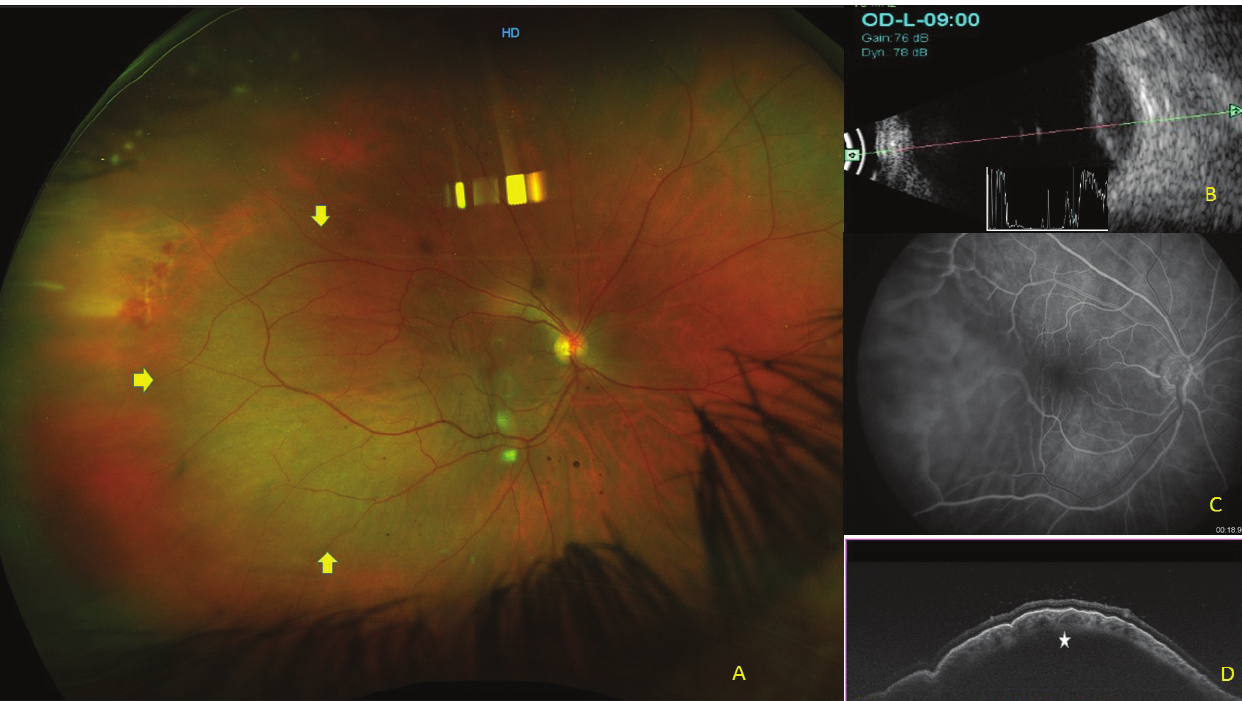
Figure 1. (A) Fundus picture: Yellow arrows show the extent of the lesion. (B) B scan shows a well-defined mass with high surface reflectivity and low internal reflectivity. No sub-Tenon’s fluid. (C) FA and ICG show normal fluorescence and late disc leakage. (D) OCT shows elevation of the retino-choroidal complex with hyporeflective lesion in outer choroid with smooth anterior surface and a vertical scan showing choroidal folds.